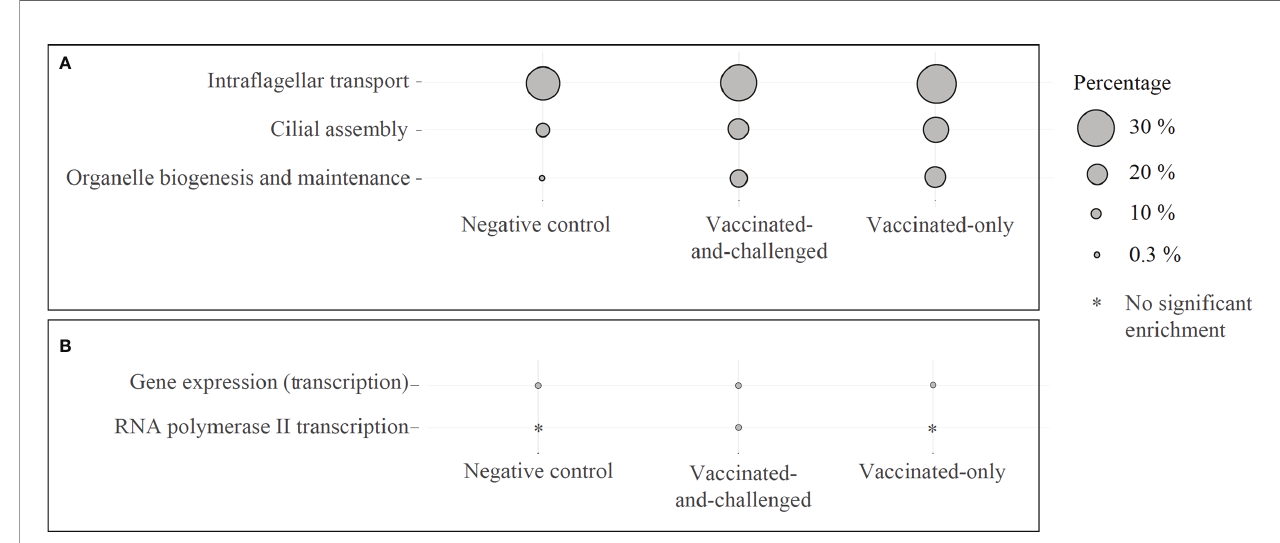
FIGURE 4 | Reactome pathways enriched with down-regulated genes in the challenged-only group compared to the negative control, vaccinated-and-challenged or vaccinated-only group. (A) Pathways involved in cilial formation, (B) pathways involved in transcription. Gray solid circles indicate the proportion of down-regulated genes out of the total number of genes in each pathway. A false discovery rate (FDR) of < 0.01 was considered signi fi